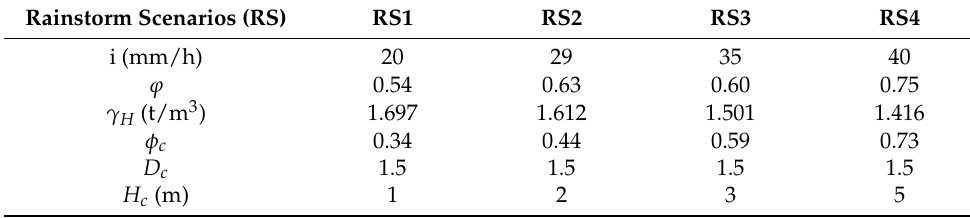
Table 2. Debris flow parameters under different rainstorm